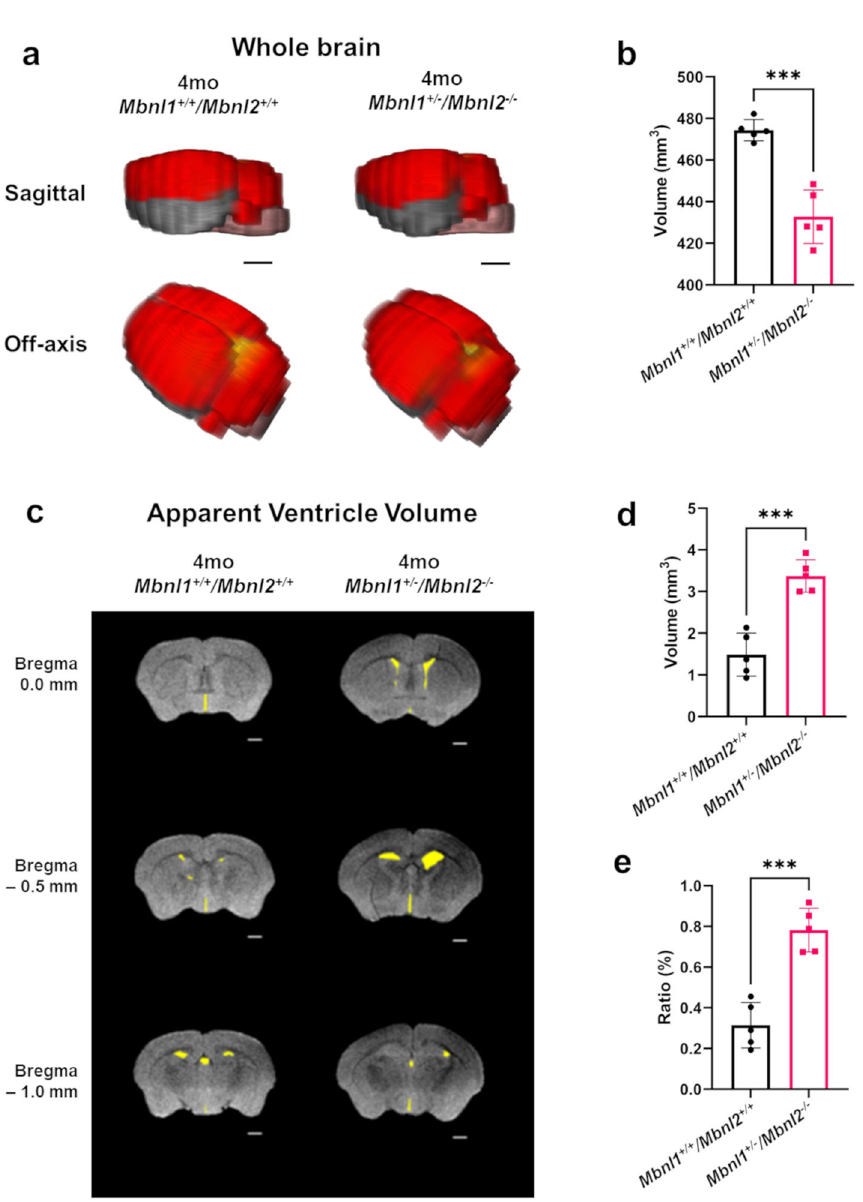
Fig. 2 Four-month-old Mbnl1 + / − /Mbnl2 − / − mice exhibit reduced whole-brain volume and enlarged ventricles. a 3D rendering of representative whole- brain 2D FSE T2w MRIs for 4mo Mbnl1 + / + /Mbnl2 + / + and Mbnl1 + / − /Mbnl2 − / − mice. Colored regions are isocortex and cerebellum (red), hindbrain (pink), white matter areas (yellow), and olfactory gray matter areas (gray). The olfactory bulb was excluded in volume measurements. Scale bar = 2.0 mm. b Whole-brain measurements (mean ± SD) are shown. c Representative axial brain slices from FSE T2w MRI scans where apparent ventricle volumes were de fi ned from hyperintense regions along ventricle locations (yellow fi lled). Scale bar in 2D axial images denotes 1 mm. d , e Apparent ventricle volumes and percent apparent ventricle/whole-brain volumes (mean ± SD) are shown. Error bars are standard deviations (SD). In all cases, * p < 0.05, ** p < 0.01, and *** p <